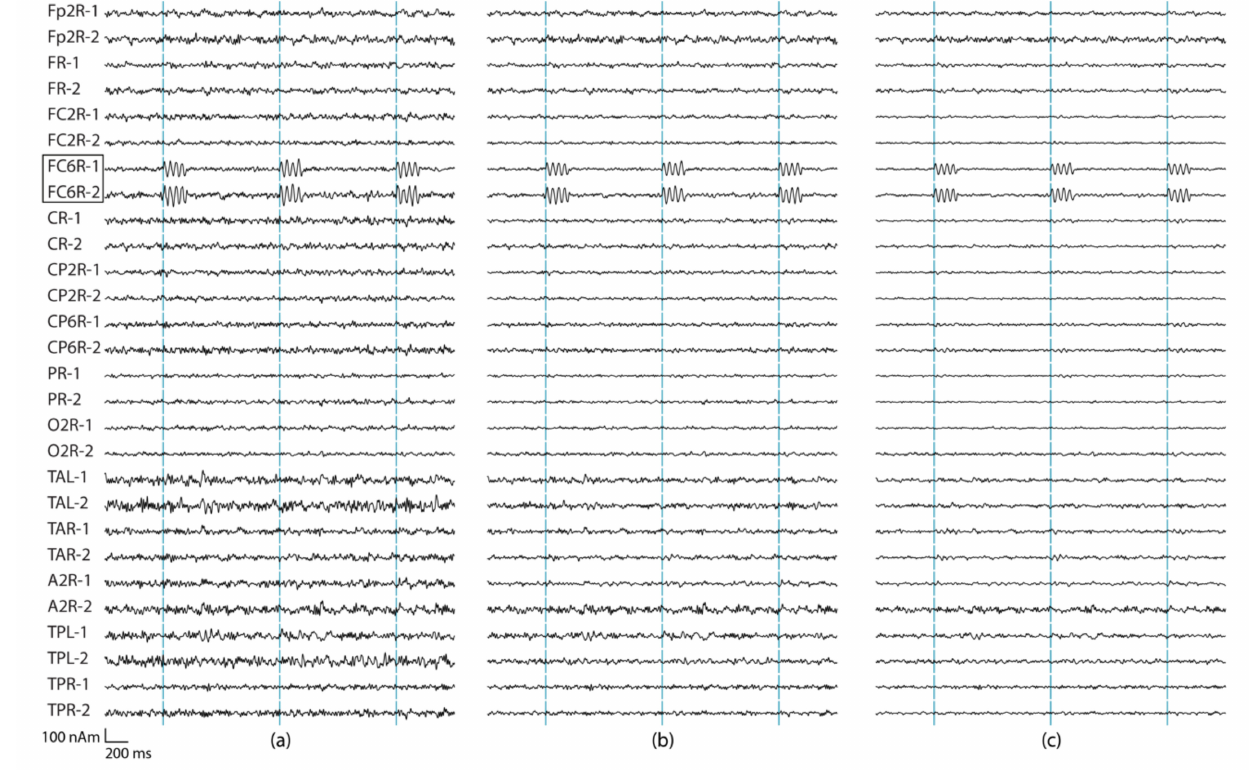
Figure 2. Source montage waveforms at a subset of 14 regional source locations estimated from all 306 channels. The simulated source was at the location FC6R. Three seconds data of the two tangential dipole orientations at each location (labeled as 1,2) are shown. Three different regularization values were used: ( a ) λ = 0%, ( b ) λ = 0.5%, and ( c ) λ =